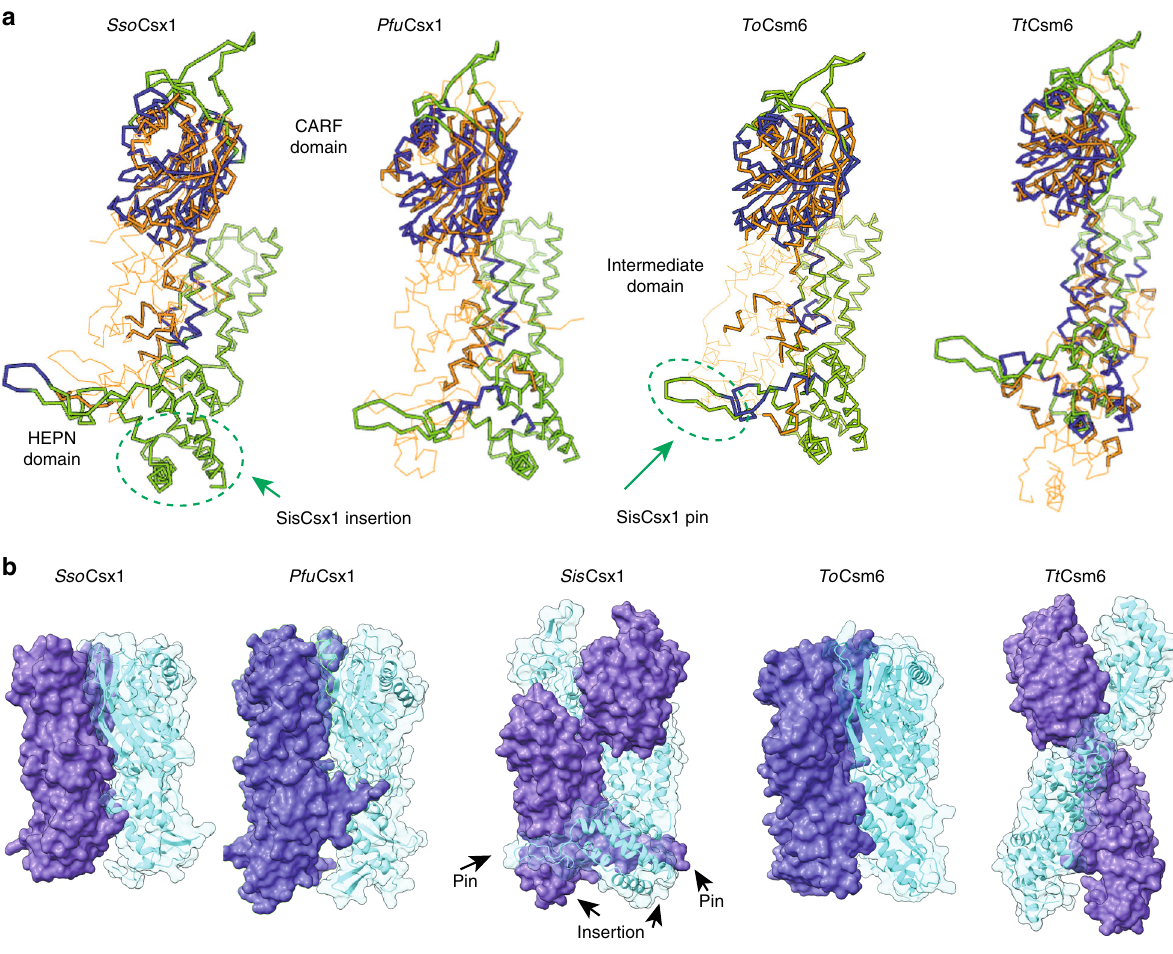
Fig. 2 Comparison between type III CRISPR-associated ribonucleases. a Structural comparison between SisCsx1 and the dimeric SsoCsx1, PfuCsx1, ToCsm6, TtCsm6. Ribbon representation of the Sis Csx1 (green) and PfuCsx1, SsoCsx1 and TtCsm6 (orange) monomers which have been superposed using the DALI server. SsoCsx1 (PDB 2I71) r.m.s.d. to SisCsx1 is 5.1 Å for 184 residues out of 376 with an identity of 20%, for PfuCsx1 (PDB 4EOG) r.m.s.d. to SisCsx1 is 6.1 Å for 200 residues out of the 466 of the protein with an identity of 12%, for ToCsm6 (PDB 6O6S) r.m.s.d. to SisCsx1 is 6.0 Å for 194 residues out of the 433 of the protein with an identity of 15%, while for TtCsm6 (PDB 5FSH) the r.m.s.d. is 5.0 Å for 224 out of the 448 of the protein with an identity of 11%. b Comparison of the dimeric arrangements of SsoCsx1, PfuCsx1, ToCsm6, TtCsm6 with